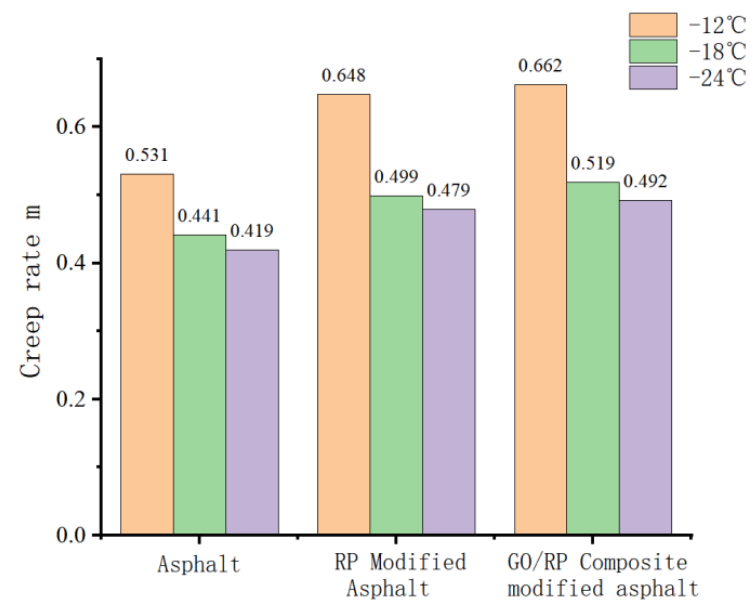
Figure 9. Creep rate of asphalt at different temperatures.